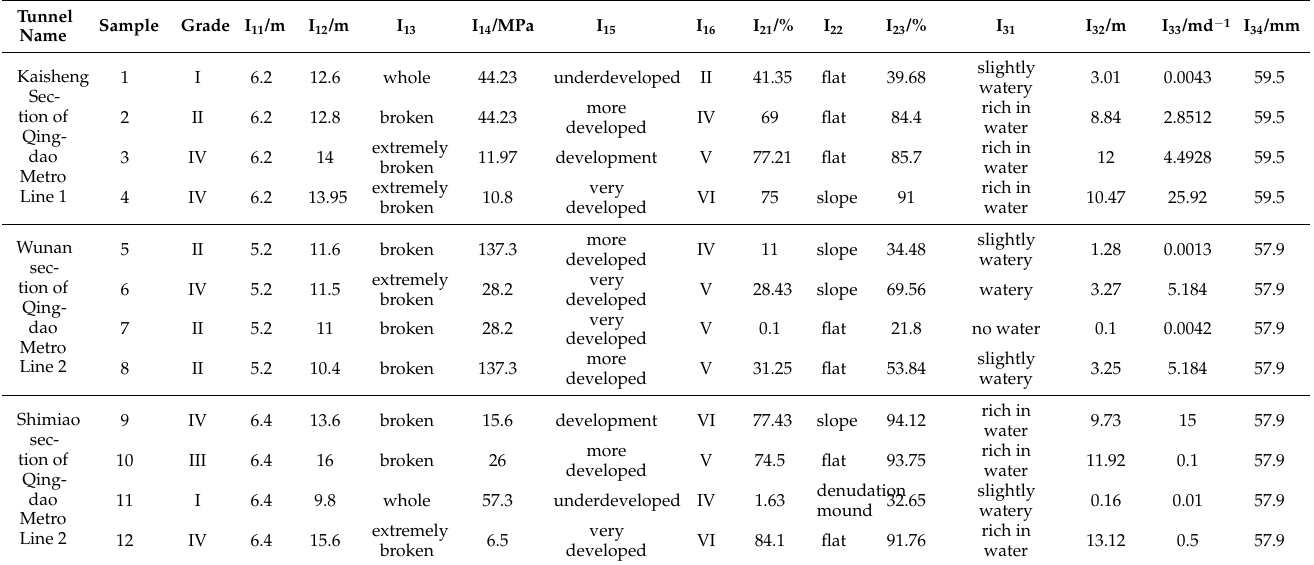
Table 5. Training sample data.